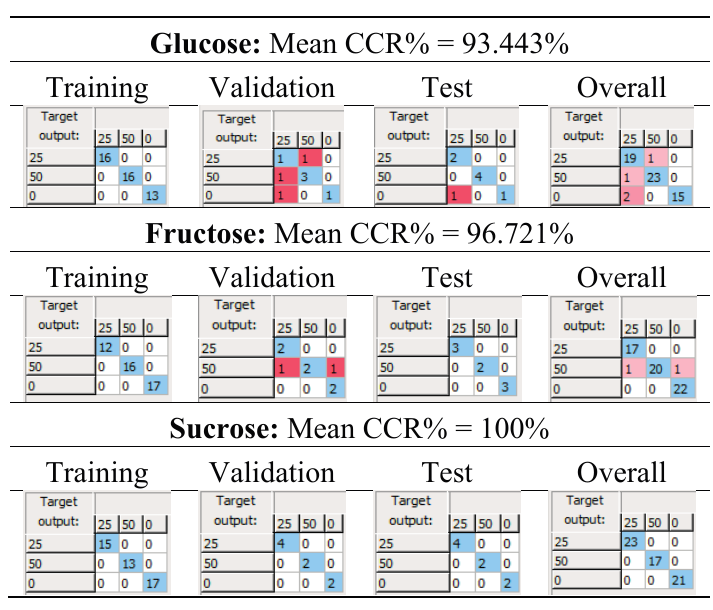
Table 3. Confusion matrices for combined sugars